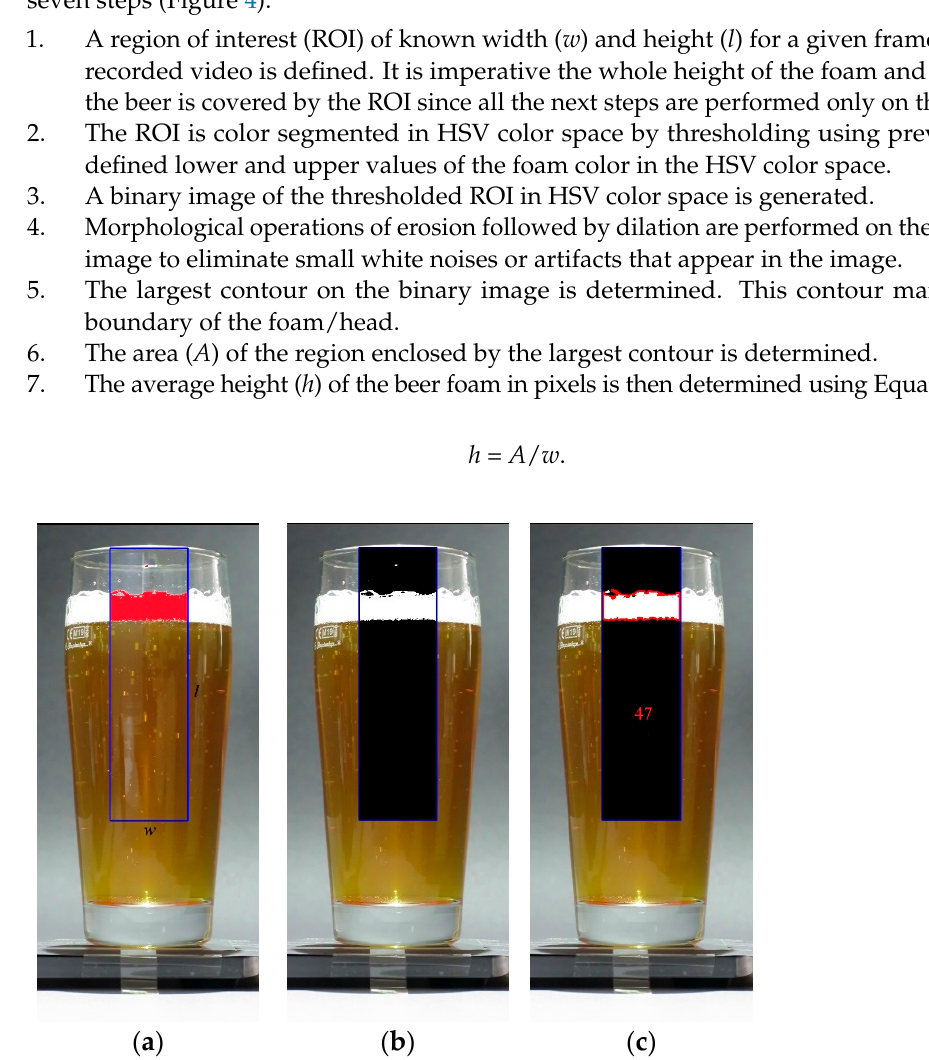
Figure 4. Estimation of foam height from image. ( a ) Region of interest (ROI) of known width ( w ) and height ( l ) is initially defined for the image. The ROI is thresholded in HSV color space. The pixels satisfying the threshold are marked in red. ( b ) Binary image of ROI thresholded in HSV color is generated. ( c ) Morphological operations of erosion followed by dilation performed on binary image to remove artifacts. The largest contour (marked in red) is found.